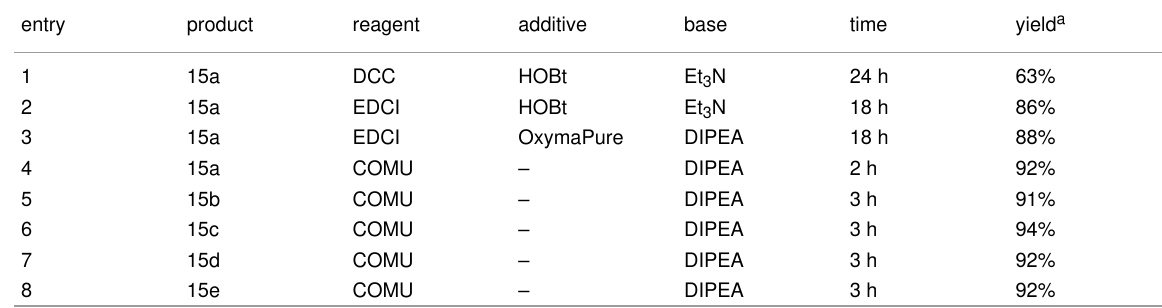
Table 3: Optimization of reaction conditions.